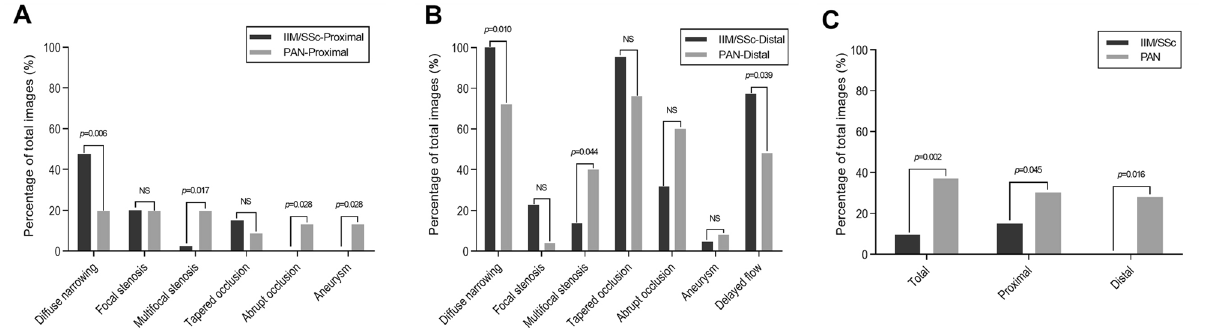
Figure 2. Angiographic parameters in the extremities of patients with IIM/SSc-vasculopathy and PAN. Angiographic features in arteries of the ( A ) proximal and ( B ) distal extremities of patients with IIM/SSc- vasculopathy and PAN. ( C ) Frequencies of neovascularization (hypertortuosity, grade 3) between the IIM/ SSc-vasculopathy and PAN. IIM idiopathic inflammatory myopathies, PAN polyarteritis nodosa, SSc systemic sclerosis. Y-axis is the percentage (%) of total